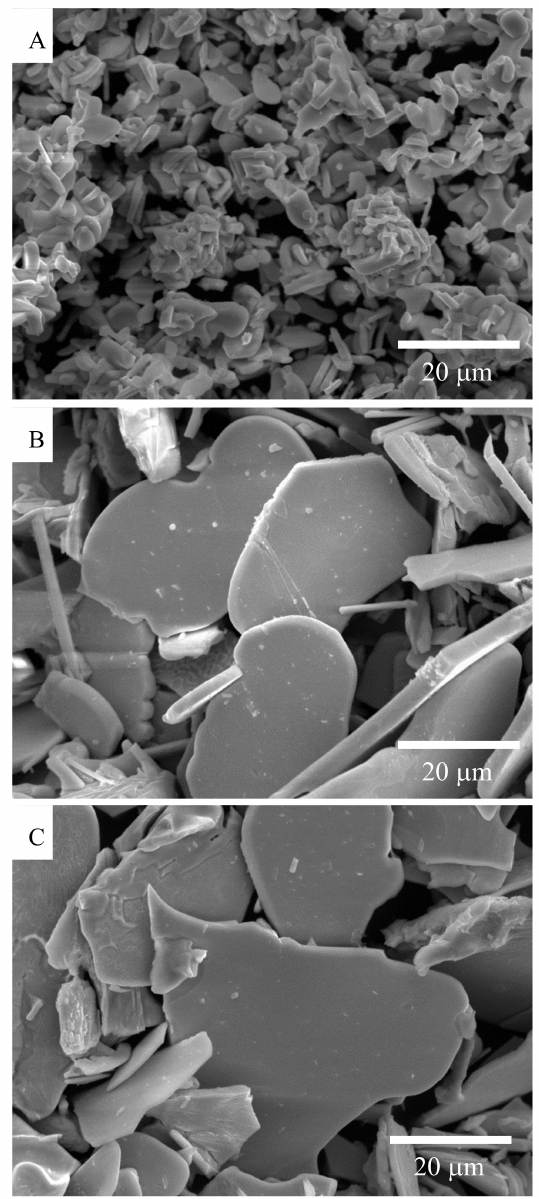
Figure 2. SEM images of BICUVOX platelets formed by MSS at: ( A ) 610 ◦ C/8 h, ( B ) 650 ◦ C/8 h, ( C ) 675 ◦ C/8